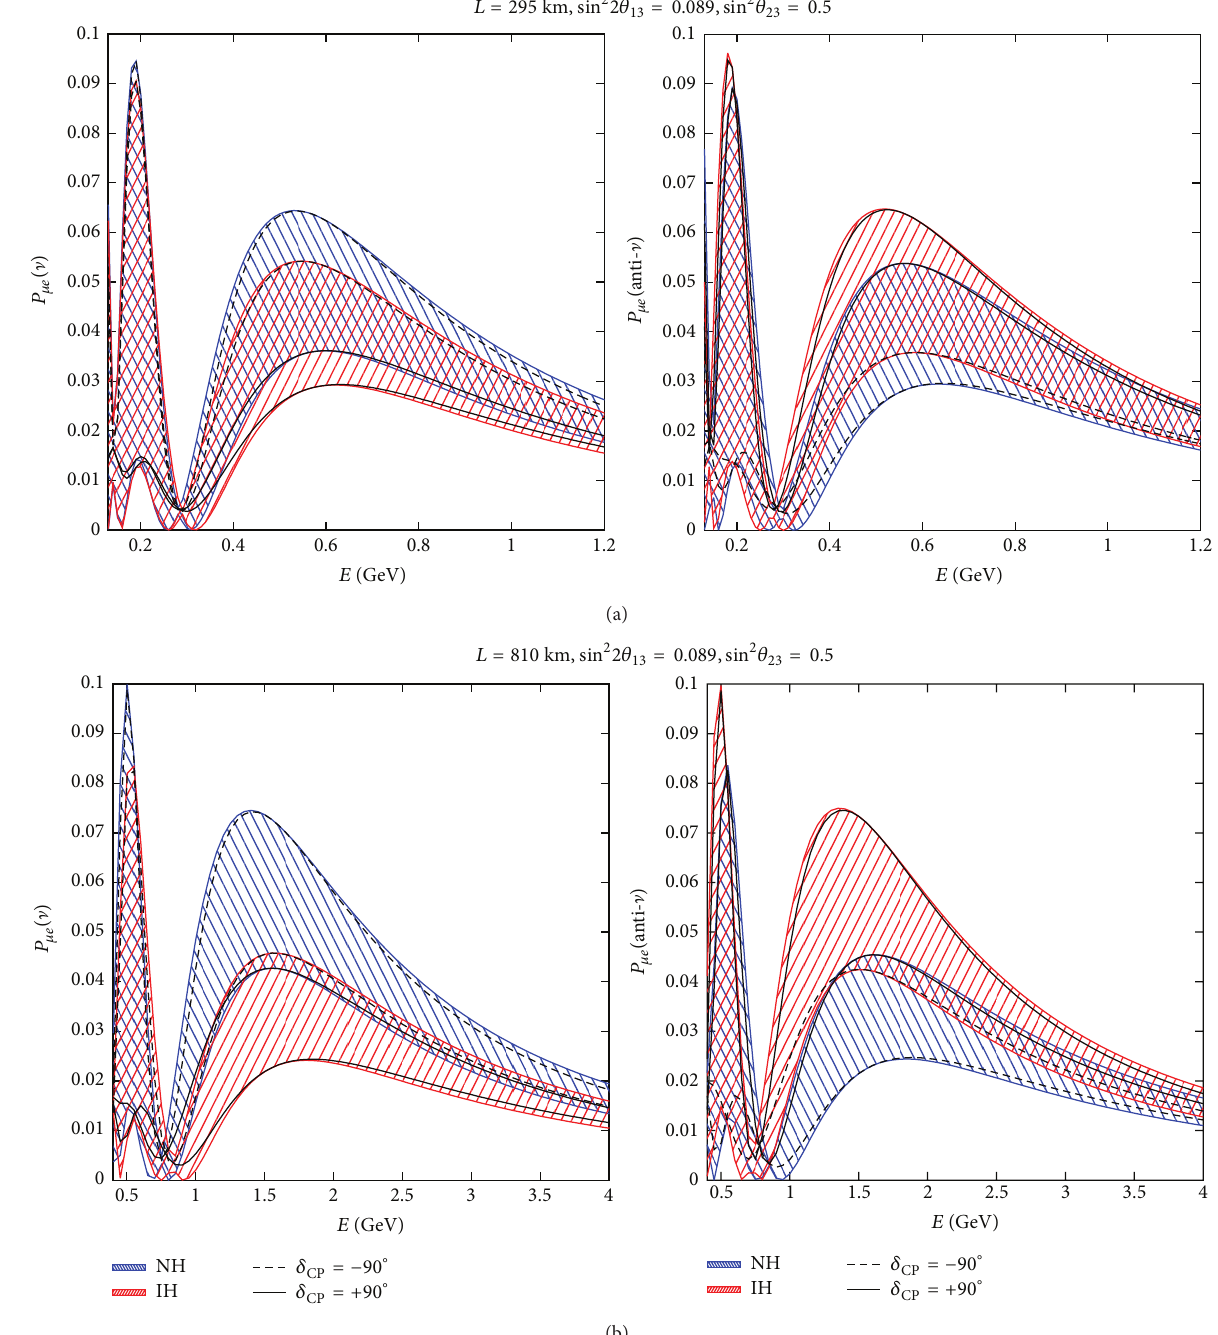
Figure 2: The transition probability 𝑃 𝜇𝑒 as a function of neutrino energy. The band reflects the effect of unknown 𝛿 = 90 ∘ ( 𝛿 = −90 ∘ ) case is shown by the solid (dashed) line. The blue (red) band is for NH (IH). The left panel (right panel) probability for 𝛿 CP CP is for ] ( ] ). The upper panels are drawn for the T2K baseline of 295 km. The lower panels are for the NO ] A baseline of 810 km. Here, we take sin 2 2𝜃 13 = 0.089 and sin 2 𝜃 23 = 0.5